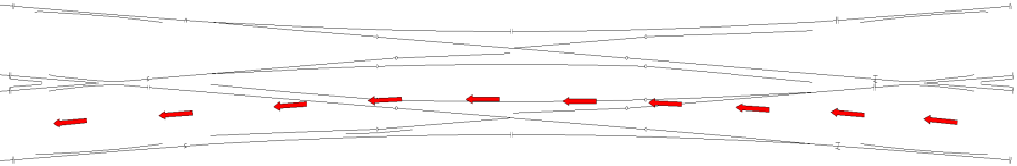
Figure 15. Side-in and side-out path in a double-slip turnout.